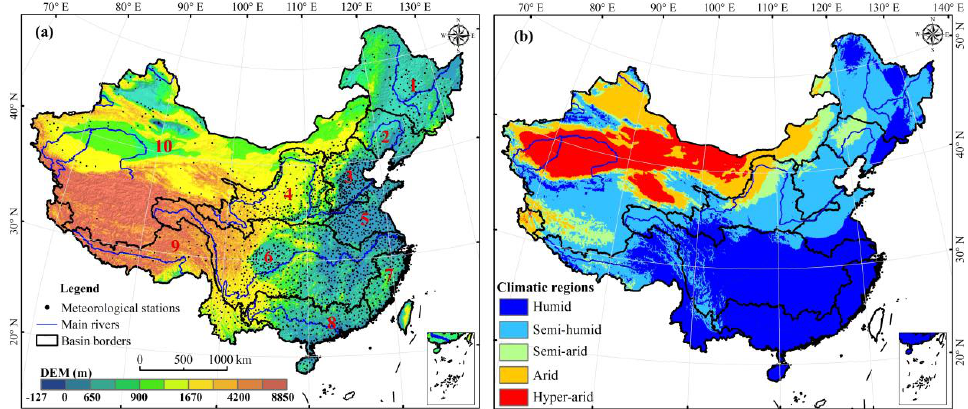
Figure 1. Location of the meteorological stations, topography, the 10 first-level water resource zones in China ( a ), and the climatic zones divided by the aridity index ( b ). The 10 first-level water resource zones are as follows: 1-the Song Hua River, 2-the Liao River, 3-the Hai River, 4-the Yellow River, 5- the Huai River, 6-the Yangtze River, 7-southeastern rivers, 8-the Pearl River, 9-southwestern rivers, 10-northwestern rivers.